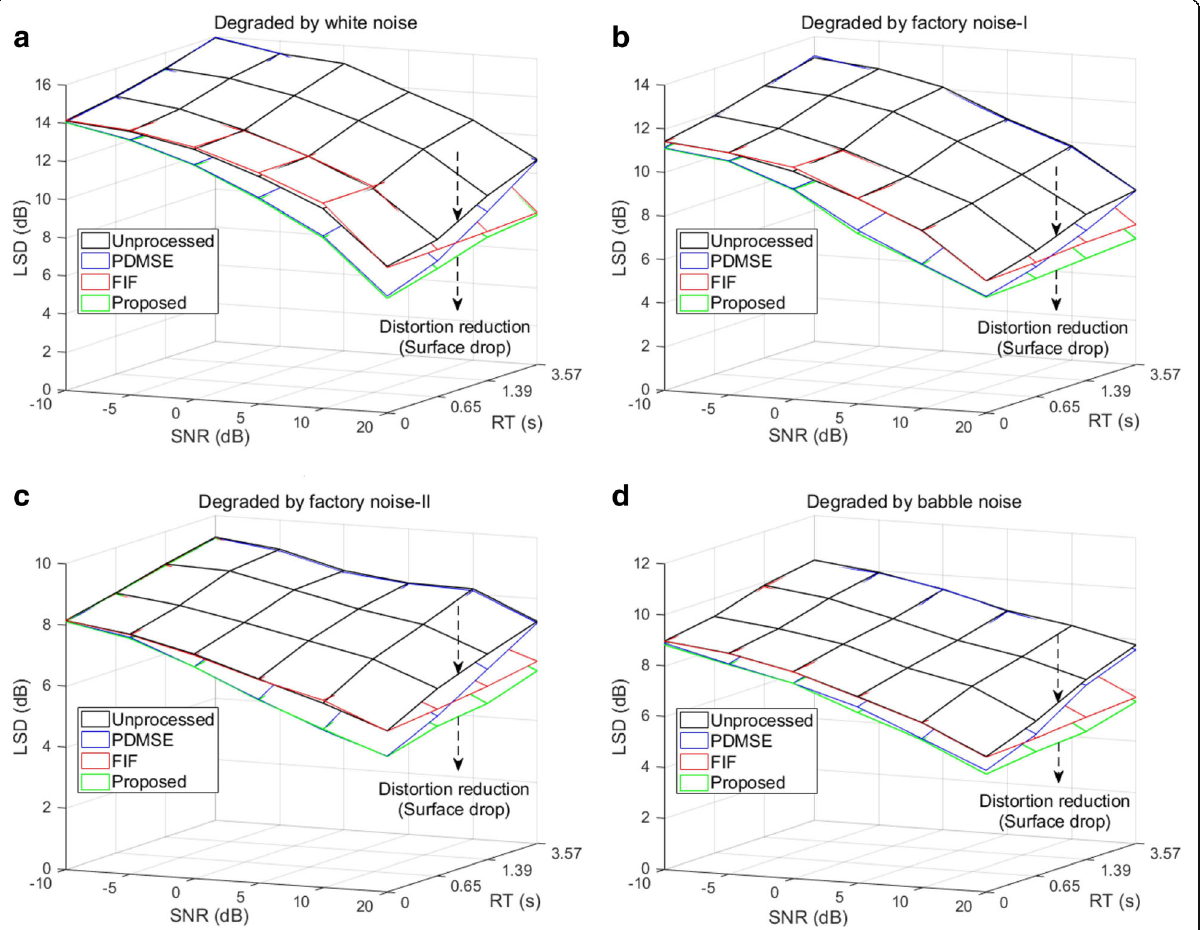
Fig. 5 Log-spectral distortion comparison of algorithms under the different noise types. a speech degraded by white noise, b speech degraded by factory noise-I, c speech degraded by factory noise-II, d speech degraded by babble